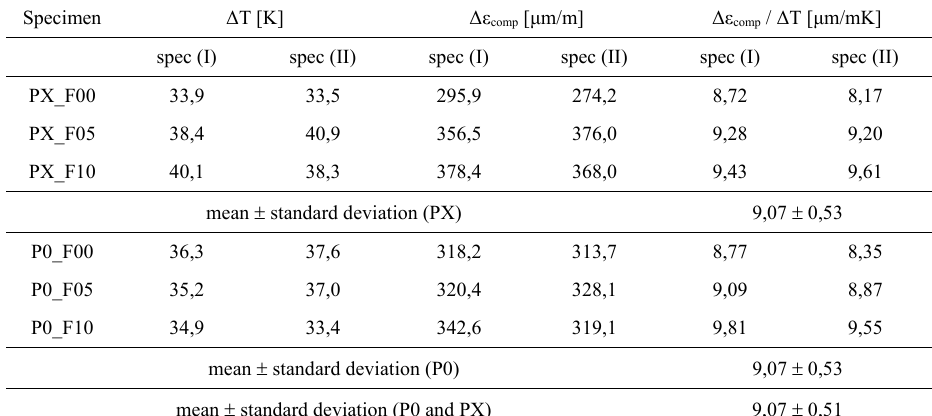
Table 2: Change in strain versus change in ambient temperature. Δ T = 36,6  2,5 K (mean  standard